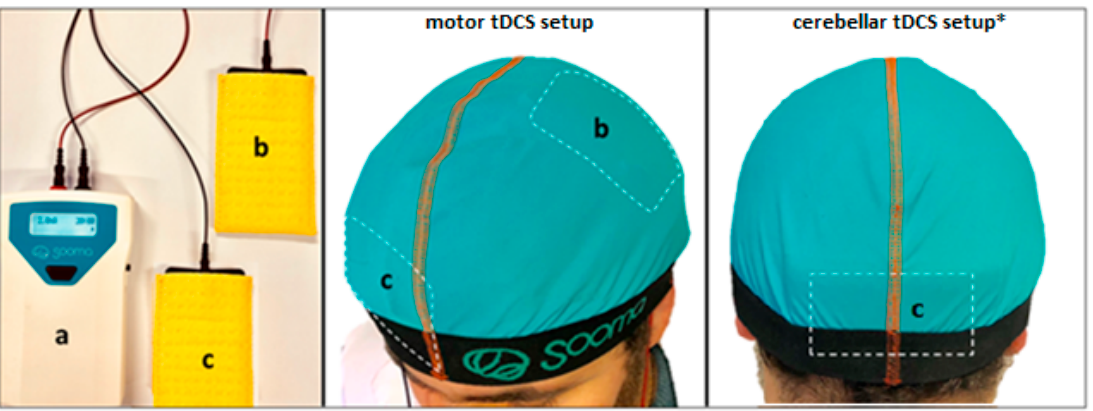
Figure 1. An illustration of a tDCS setup (Sooma Oy, Helsinki, Finland). a. Battery-driven stimulator. b. Anode. c. Cathode. * The reference electrode over the shoulder is not shown.